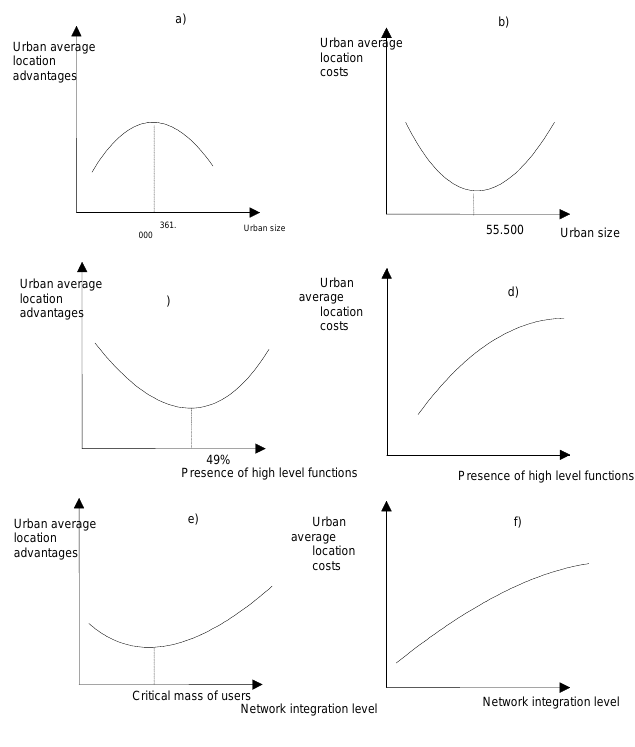
Figure 2: Urban Average Location Advantages and Cost for Different Urban Sizes, Higher Urban Functions and Degree of